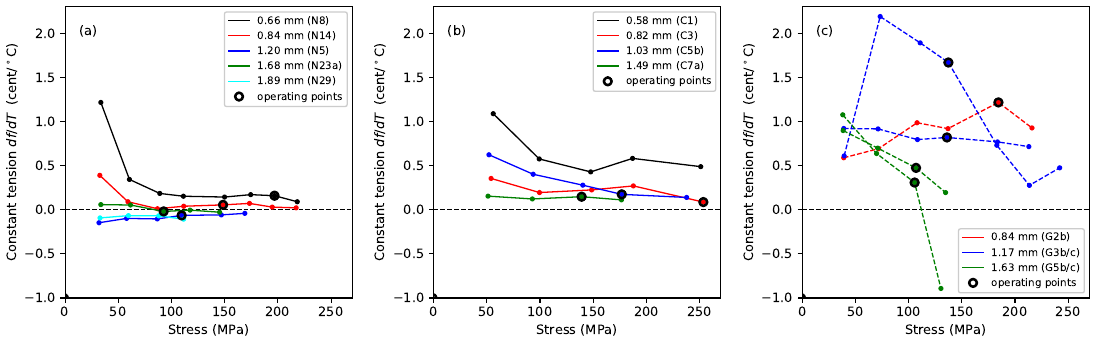
Figure 9. The thermal tuning sensitivity for the strings held at constant tension, for ( a ) nylon, ( b ) fluorocarbon, and ( c ) gut. Black circles show the results at the expected operating